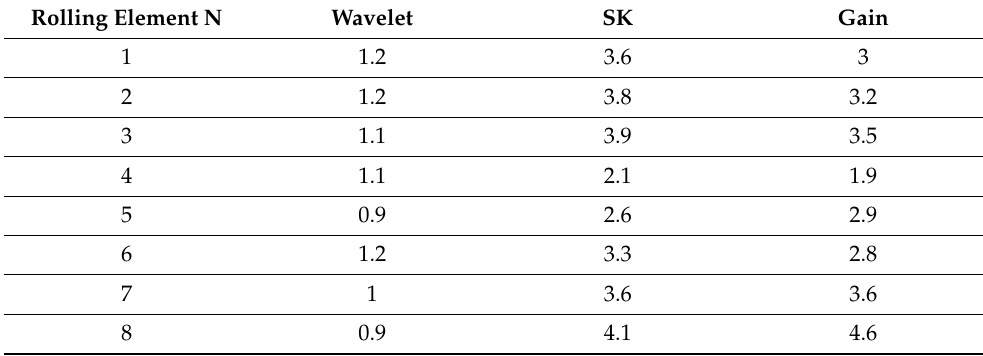
Table 3. Comparison of FC for the wavelet approach [5] and the proposed approach.